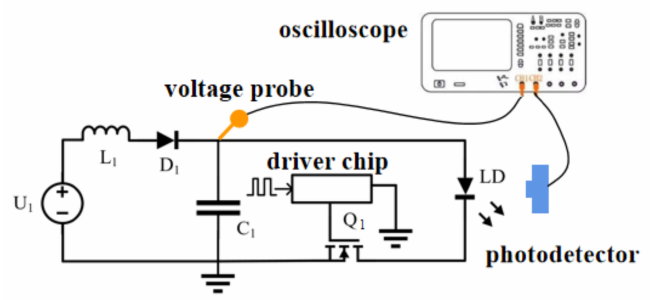
Figure 2. Schematic diagram of the laser diode drive circuit and the test platform.